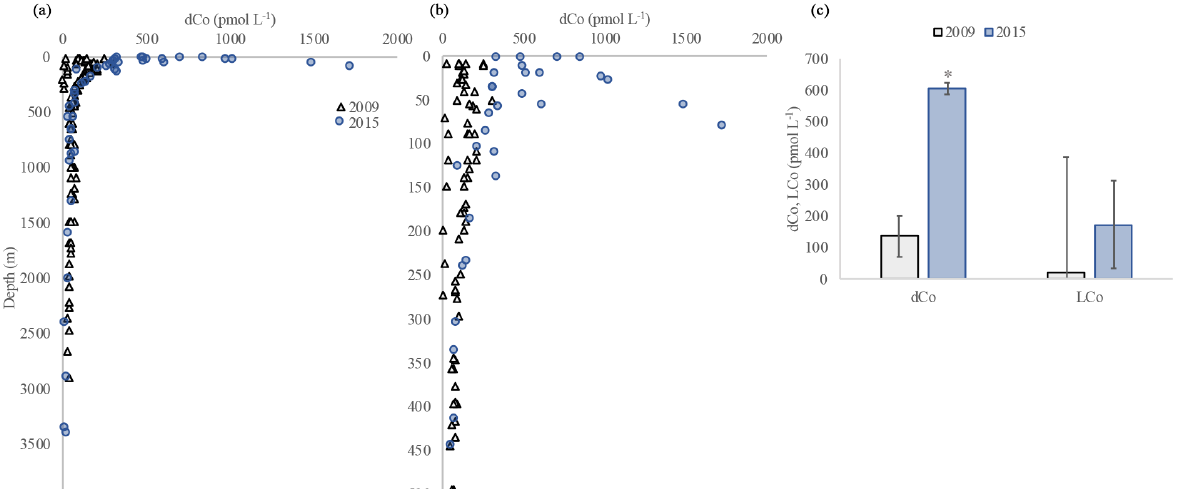
Figure 14. The dCo on the shelf measured in 2009 (GIPY14; black triangles) and 2015 (GN01; blue circles) in the upper 3500m (a) and upper 500m (b) . Average dCo and LCo in the upper 150m from 2009 (grey) and 2015 (blue; c ). Error bars represent the standard deviation, and * denotes a significant difference.